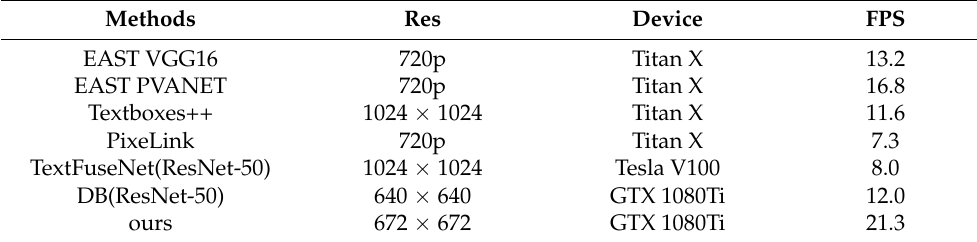
Table 2. Runtime and performance comparison on ICDAR 2015 incidental text